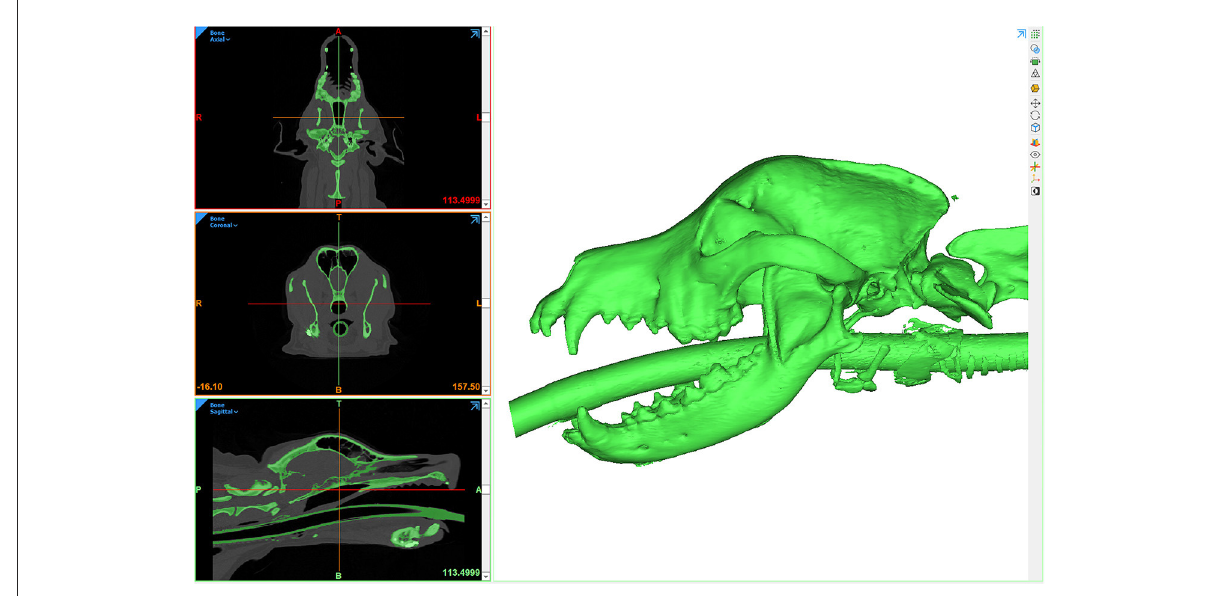
FIGURE2 Computer screenshot depicting an automated thresholding process for segmentation and 3D computer model generation.